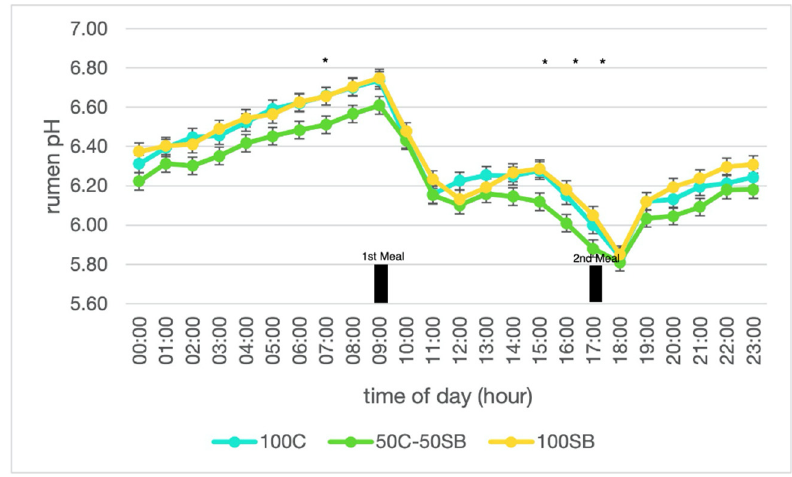
Figure 1. The effects of replacing ground corn with sugar beet root on the daily variations in the rumen pH of early-lactating dairy cows. * Significant differences ( p < 0.05) among dietary treatments. Error bars denote standard error of the mean; 100C, control diet with ground corn as energy supplement; 50C-SB, diet with 50% ground corn and 50% sugar beets as energy supplements; 100SB, diet with 100% sugar beet as energy supplement.